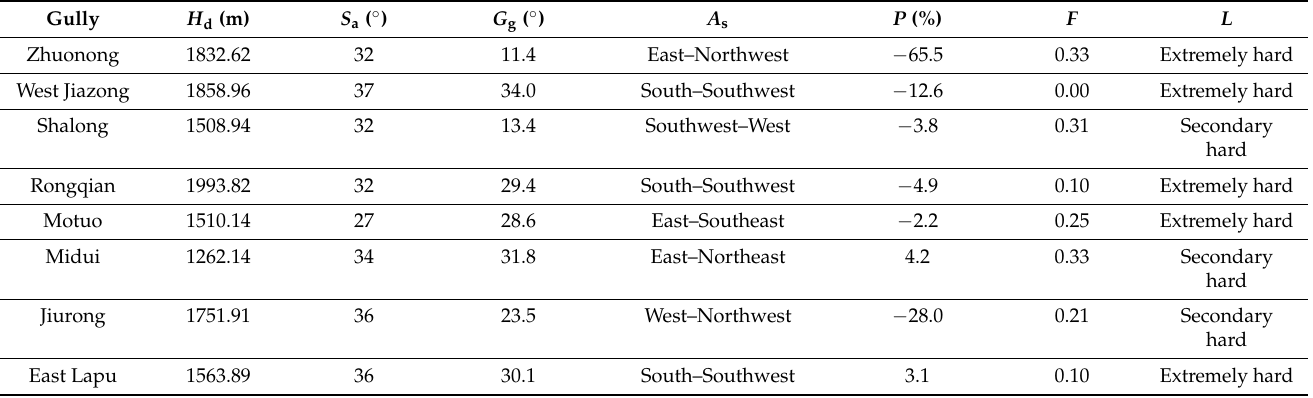
Table 5. Topographic and geological characteristics of the eight debris flow gullies in the training